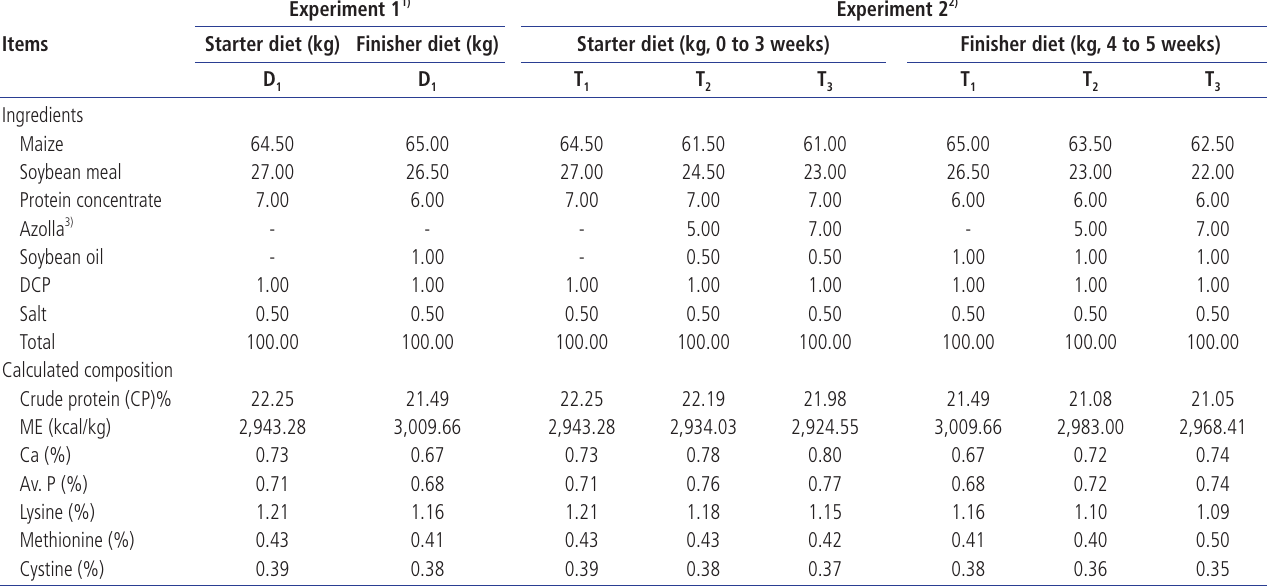
Table 1. Composition of diet used in the experiment